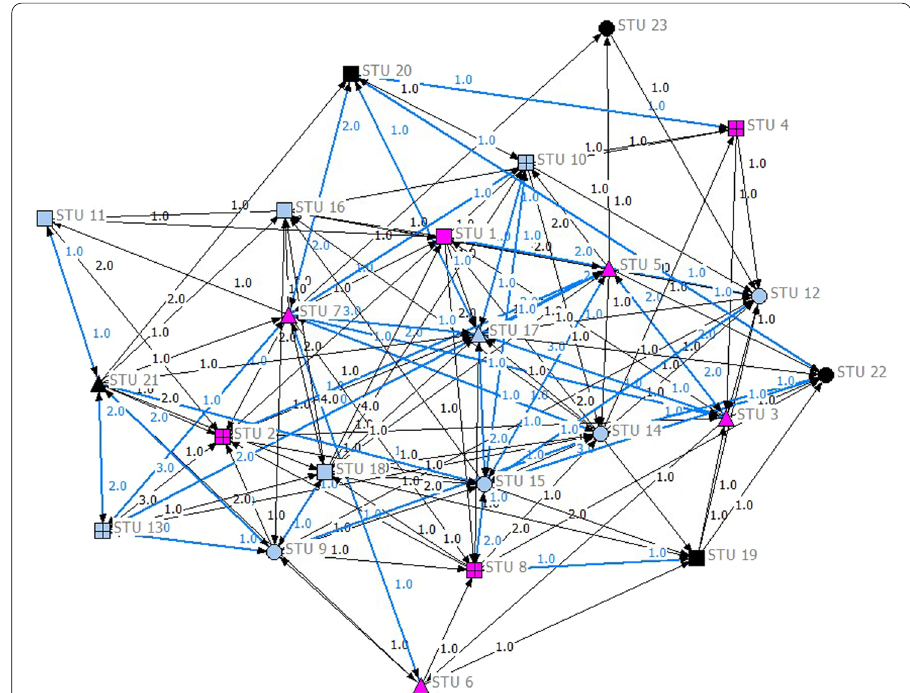
Fig. 6 Social network interaction pattern for the GAFCC-F group (including original posts and peer comments). Notes The pink nodes indicate students with final scores from 85 to 100 (A grade); the blue nodes indicate students with final scores from 75 to 84 score (B grade); the black nodes indicate students with final scores from 60 to 74 (C grade). Blue ties refer to reciprocal ties, and black ties are non-reciprocal ties. There were four study groups in this course, all formed by students exercising free choice. A circle (open circle) indicates Group 1; a square (open square) indicates Group 2; an upwards pointing triangle (open triangle) indicates Group 3; a box (open box) indicates Group